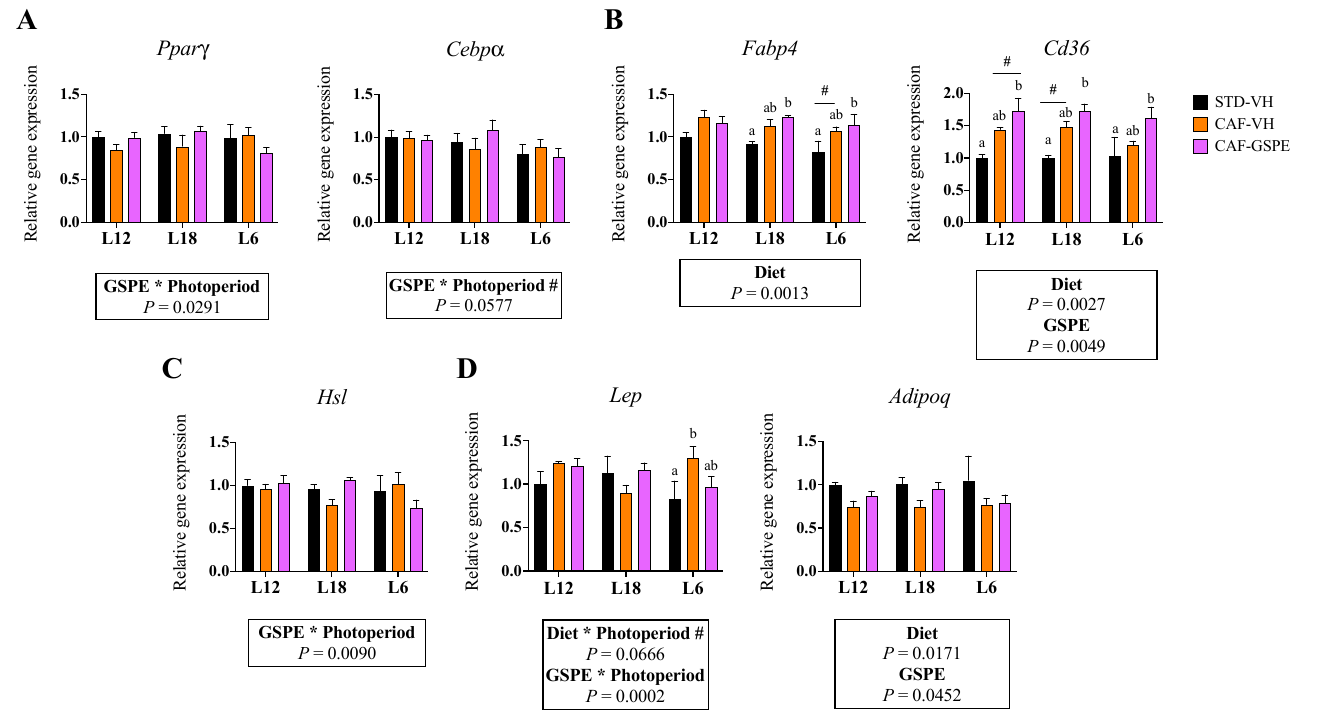
Figure 4. Effect of grape seed proanthocyanidin extract (GSPE) consumption at different photoperiods, 12 h of light:12 h of darkness (L12); 18 h of light:6 h of darkness (L18); 6 h of light:18 h of darkness (L6) on the expression of gens related to adipogenesis, lipid transport, lipolysis and adipokines in epididymal white adipose tissue (eWAT) of diet-induced obese rats. Fisher 344 rats were fed standard diet (STD) or cafeteria diet (CAF) for 9 weeks and treated with GSPE (25 mg/kg body weight) or vehicle (VH) the last 4 weeks of the study; STD-VH group; CAF-VH group; CAF-GSPE group, under different photoperiods; L12, L18 or L6. The expression of genes involved in adipogenesis ( A ), lipid transport ( B ), lipolysis ( C ) and adipokines ( D ) was measured by qPCR and normalized by Ppia . The relative expression (presented as fold-change) of CAF-VH and CAF-GSPE was normalized to the corresponding STD-VH control group (L12 photoperiod). Significant differences were assessed through two-way ANOVA analysis ( P < 0.05). Diet: diet effect within VH groups; GSPE: GSPE consumption effect within CAF groups; Diet * Photoperiod: interaction effect between diet and photoperiod within VH groups; GSPE * Photoperiod: interaction effect between GSPE consumption and photoperiod within CAF groups; #: tendency: 0.05 < P < 1. Different letters denote significant differences within each photoperiod group (assessed with two-way ANOVA followed by Tukey’s post hoc test, p < 0.05; # : tendency: 0.05 < P < 1)